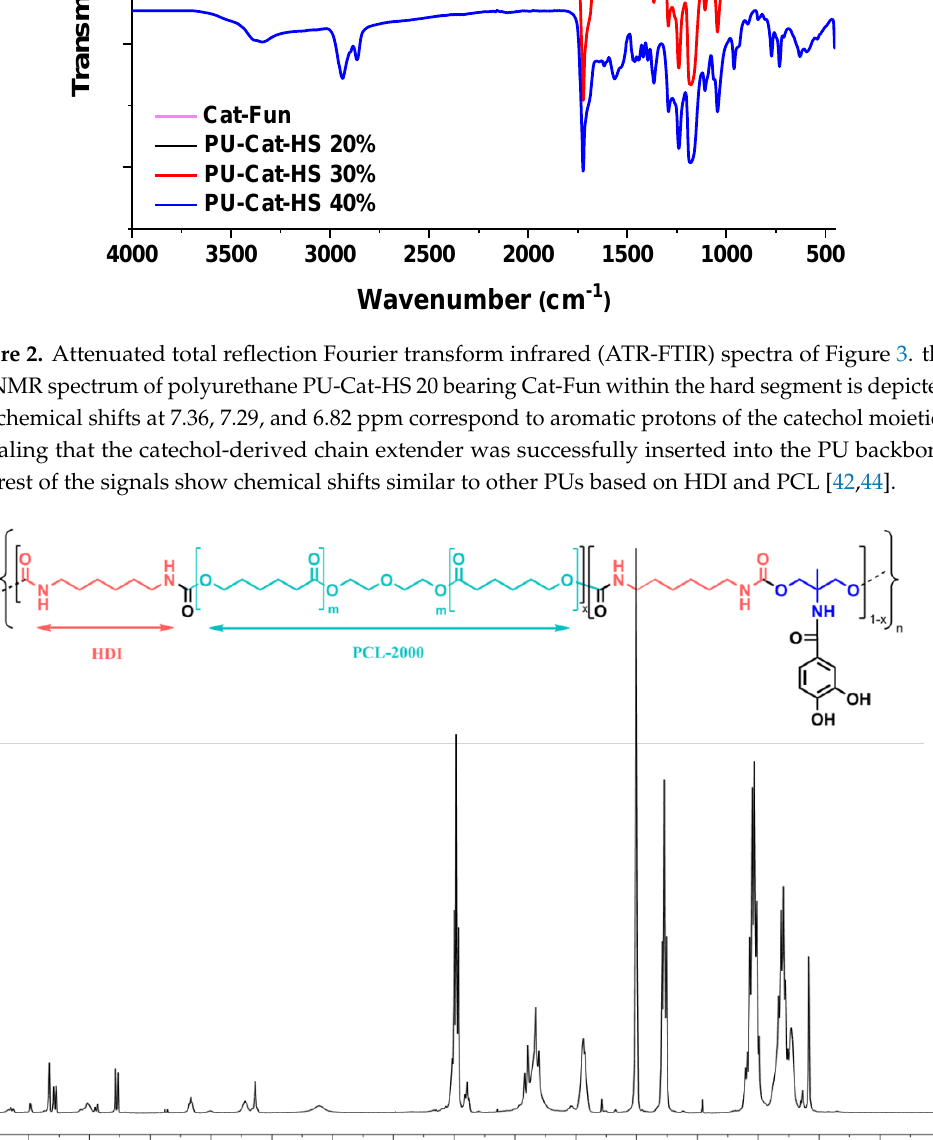
Figure 4. DSC thermograms of segmented polyurethanes bearing catecholic motifs into the hard domains. In the case of PU-Cat-HS 20, only two thermal phenomena were observed, while three thermal transitions were detected for its analogues. For the three systems, firstly, a glass transition temperature (T g ) of the soft segment (PCL) was detected at −59 °C and then a melting temperature